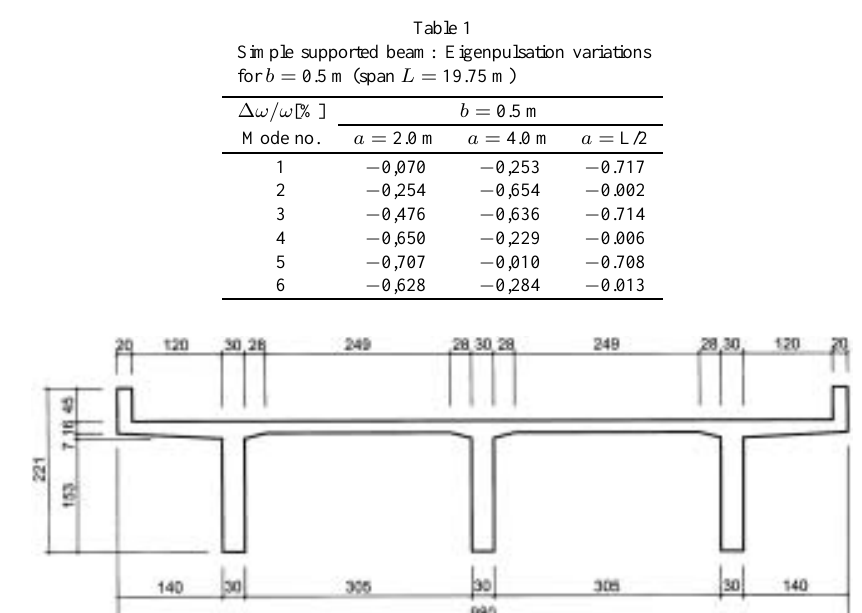
Table 1 Simple supported beam: Eigenpulsation variations